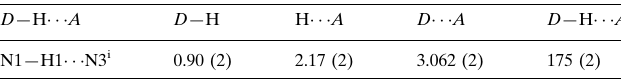
Hydrogen-bond geometry (A˚ , (cid:1)